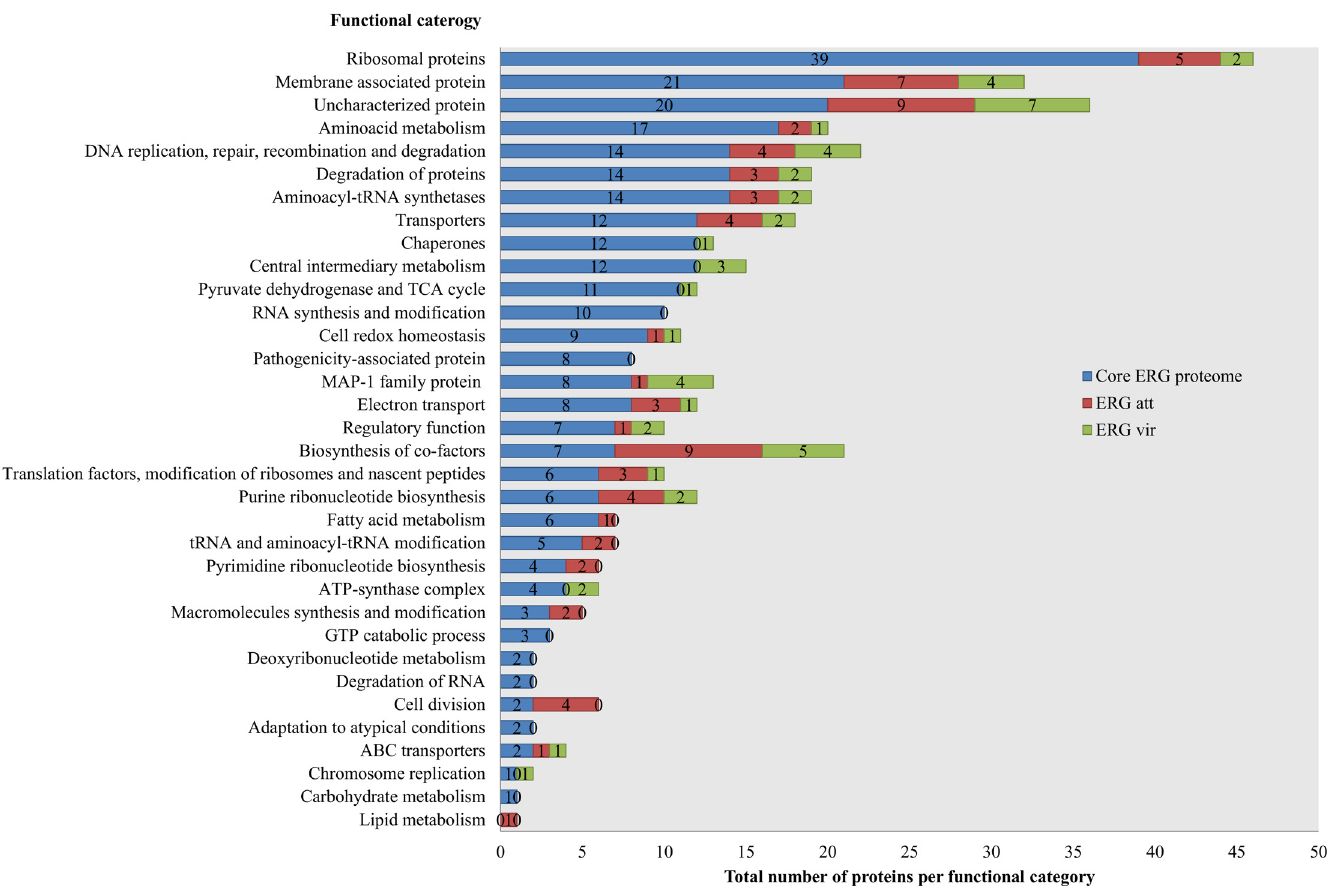
Fig 2. Functional distribution of the identified proteins in ERGvir (green) and ERGatt (red) by 1DE- nanoLC-MALDI-TOF/TOF and after Peaks software analysis (using simultaneously Peaks DB, MASCOT and X!Tandem algorithms). The proteins constituting the core proteome are depicted in blue. The number of identified proteins associated with each COG functional category is shown in the X axis (total number) and in the graph bars (number per strain, n = 3).